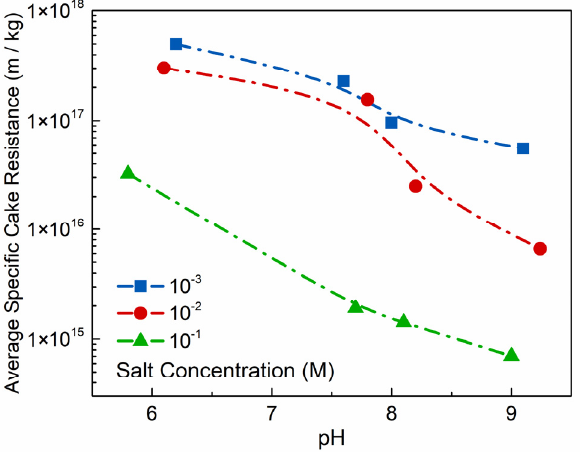
Figure 11. The changes in average specific cake resistance through the filtration process with respect to increasing salt concentration as a function of pH.